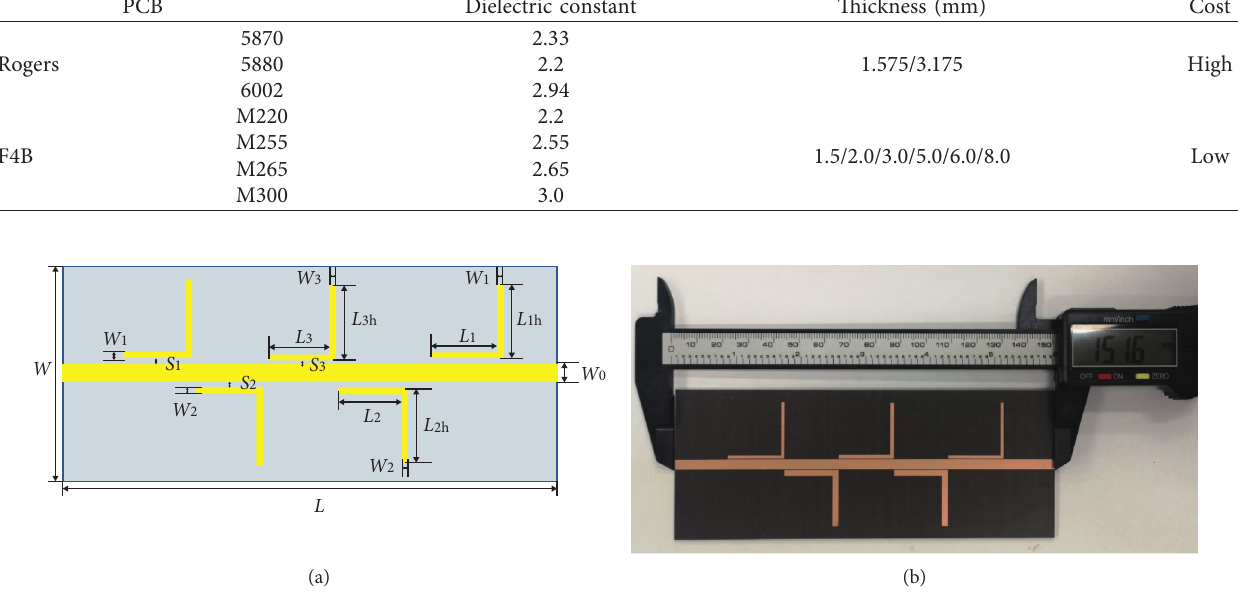
Figure 11: The photograph of the MSBSF. (a) The final layout; (b) the fabricated MSBSF. Table 2: The optimized dimensions of the